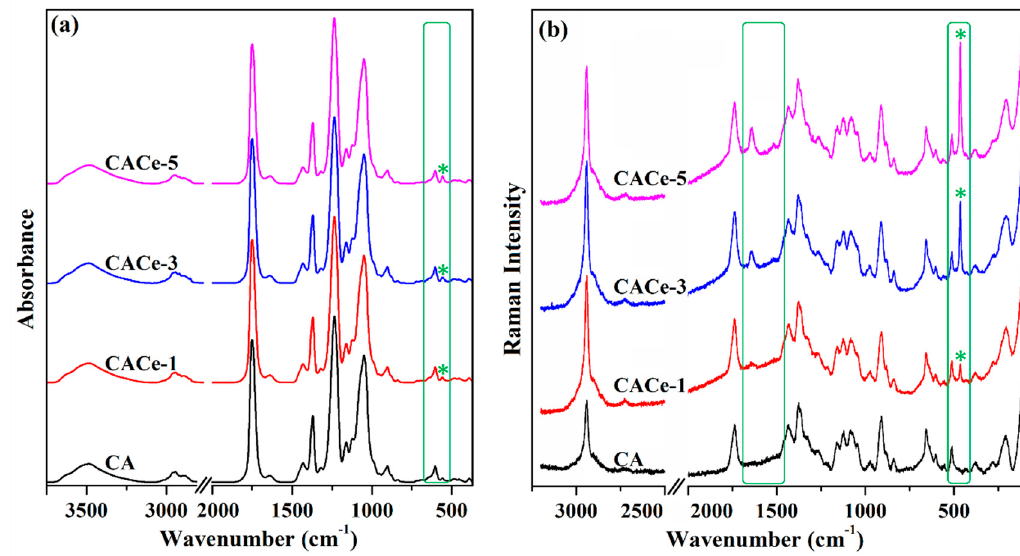
Figure 4. FTIR ( a ) and Raman ( b ) spectra of cellulose acetate and of the hybrid films CACe-1, CACe-3 and CACe-5 (* indicates Ce–O stretching vibration).